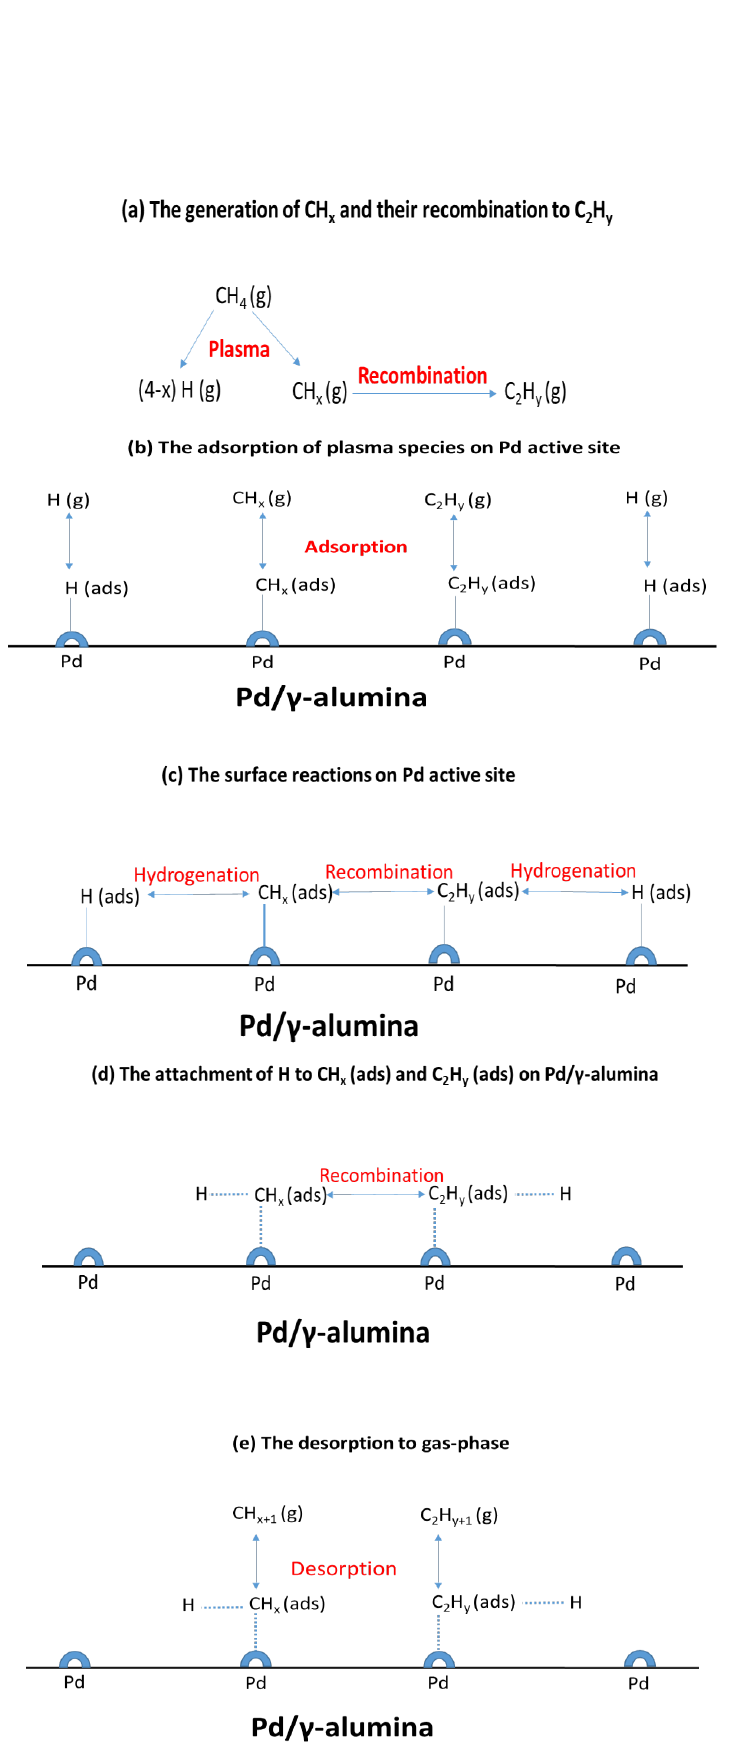
Figure 9. The mechanism of the catalytic coupling of methane to form C 2 products by interaction of DBD plasma-generated radicals with the surface of Pd / γ -alumina: ( a ) The radical generation by plasma activation, ( b ) The adsorption of radicals on the catalyst surface, ( c ) The surface reactions by interacting with Palladium active sites, ( d ) The hydrogen attachment and the recombination reactions ( e ) The desorption of CH x and C 2 H y to gas-phase.